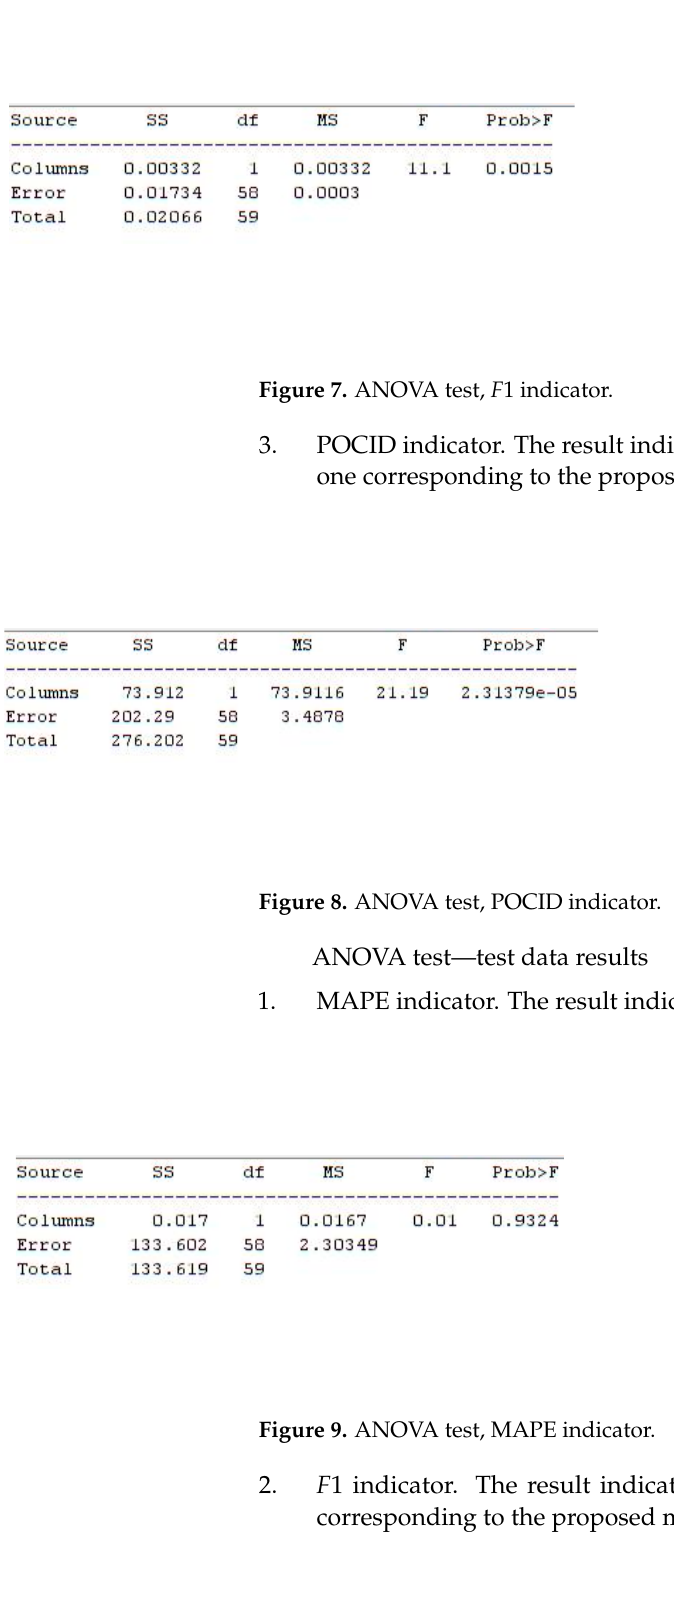
Figure 10. ANOVA test, F 1 indicator. 3. POCID indicator. The result indicates a dissimilarity between the POCID values, the one corresponding to the proposed method being significantly better. Figure 11. ANOVA test, POCID indicator. The results of training and testing the LSTM neural network to implement (25) using an ADAM optimizer are depicted in Figure 12. The actual values of BTC–USD time series